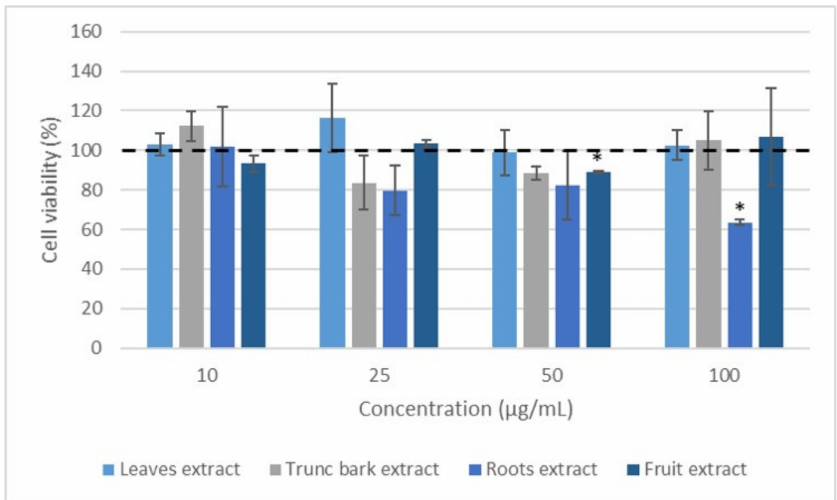
Figure 7. Effect of Vitex madiensis extracts on leukocyte viability. Blood cells were treated with the indicated concentrations of extracts, in the presence of PMA for 24 h. Data were shown as means ± SEM (Control = 100%), * p < 0.05 compared with